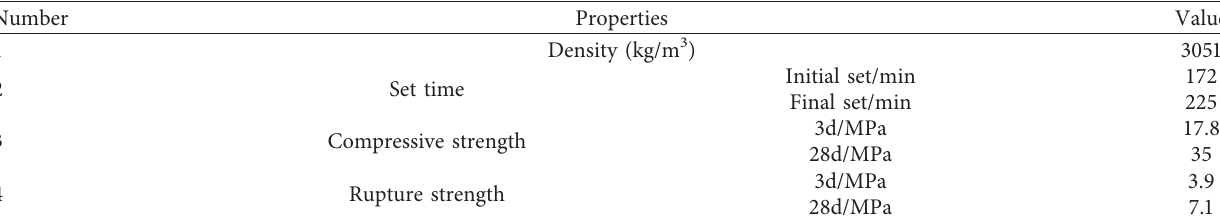
Figure 1: Cube specimen geometry size (unit: mm). Table 1: Main properties of PM32.5 cement.